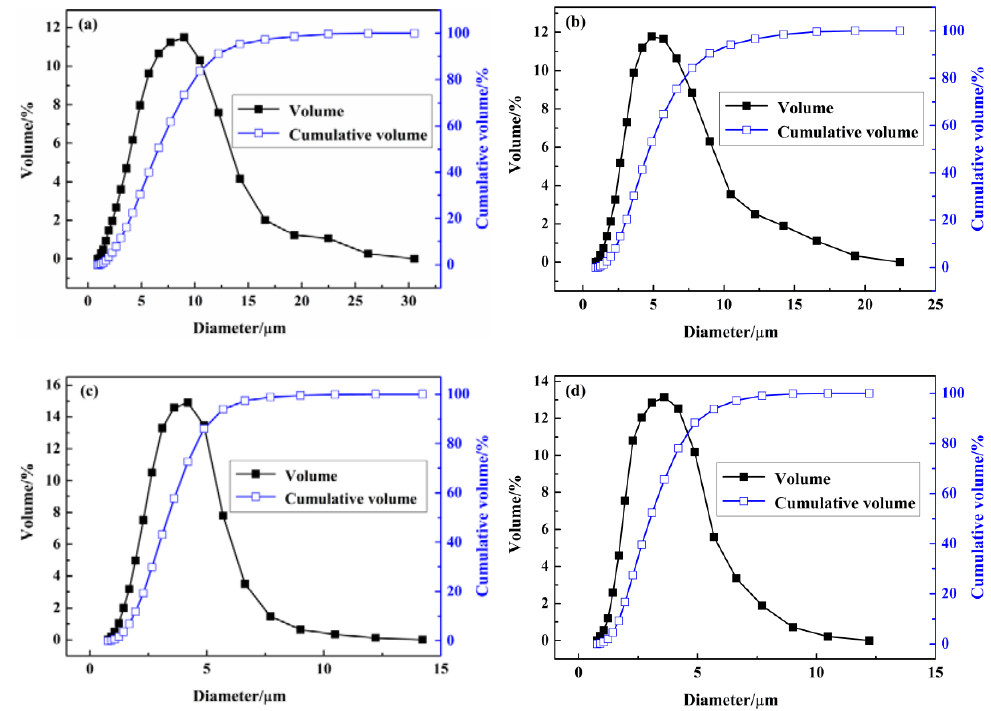
Figure 1. The influence of emulsification stirring speed on the particle size and distribution of the prepared MicroPCMs: ( a ) 3000 rpm, ( b ) 4000 rpm, ( c ) 5000 rpm, ( d ) 6000 rpm.